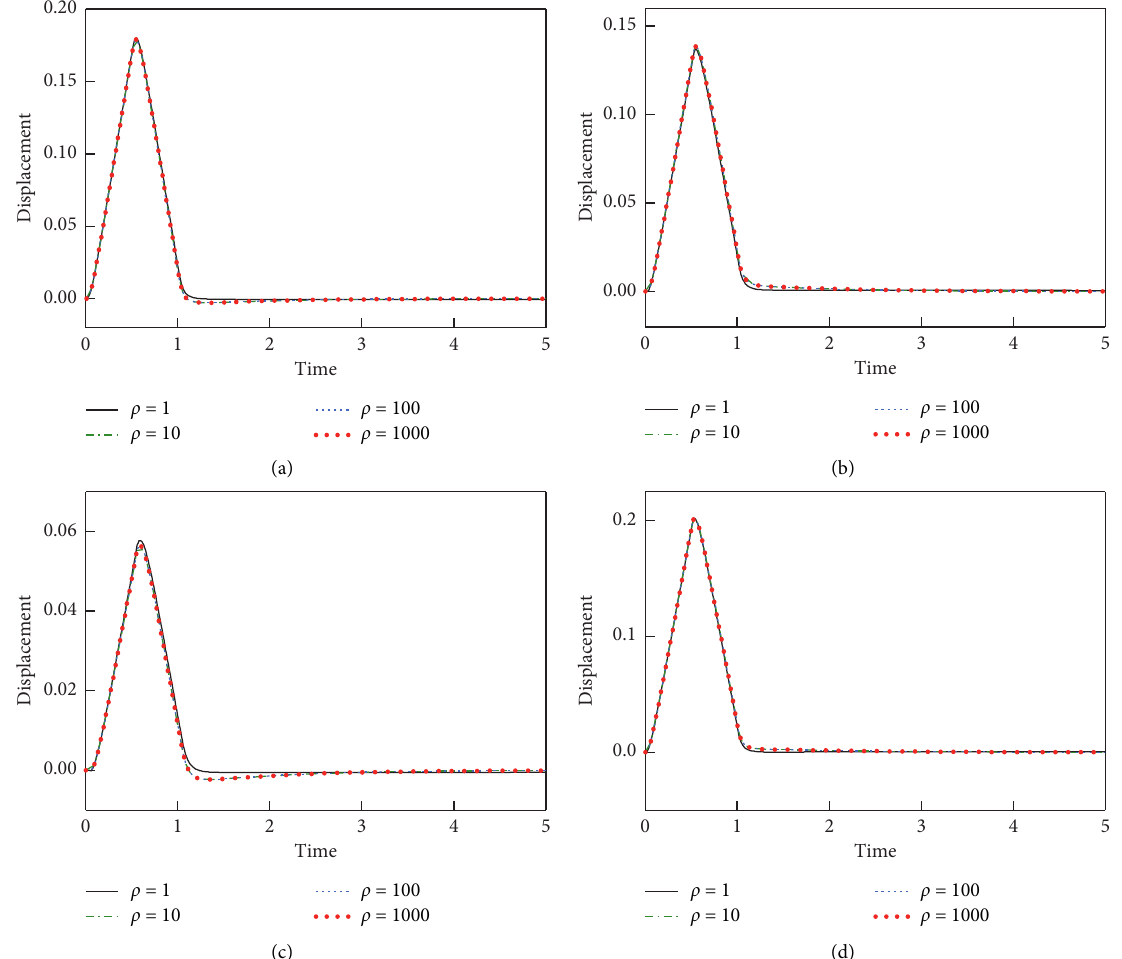
Figure 9: Effects of different mass densities of the boundary elements on the Y -direction displacement at the observation points: (a) node (A), (b) node (B), (c) node (C), and (d) node D.